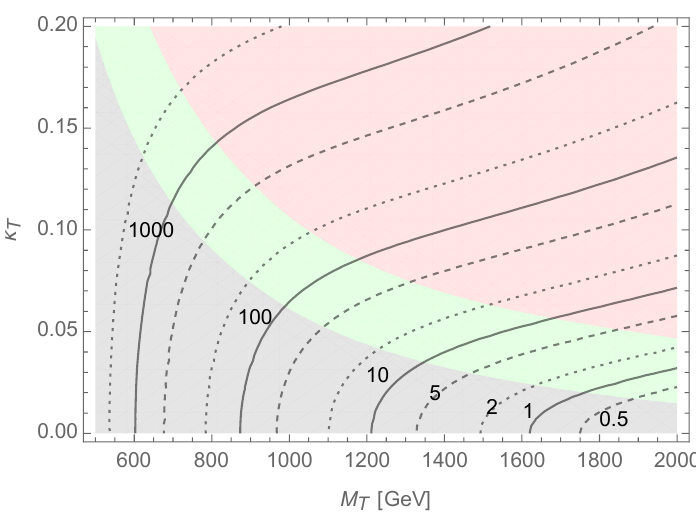
Figure 4 . Di-Higgs (total) production cross section at the LHC shown as contours in the ( M Q ; (cid:20) Q ) plane. The results, to be read in fb, contain both the single VLQ and VLQ-pair components and we represent as coloured regions the parameter space areas where a given production channel dominates (QCD-induced VLQ pair production in grey, EW-induced VLQ pair production in red and Qh -induced production in green). Direct (loop-induced and tree-level t -channel VLQ exchange) di-Higgs production has been neglected as the corresponding new physics contributions are always subleading for the parameter space regions under